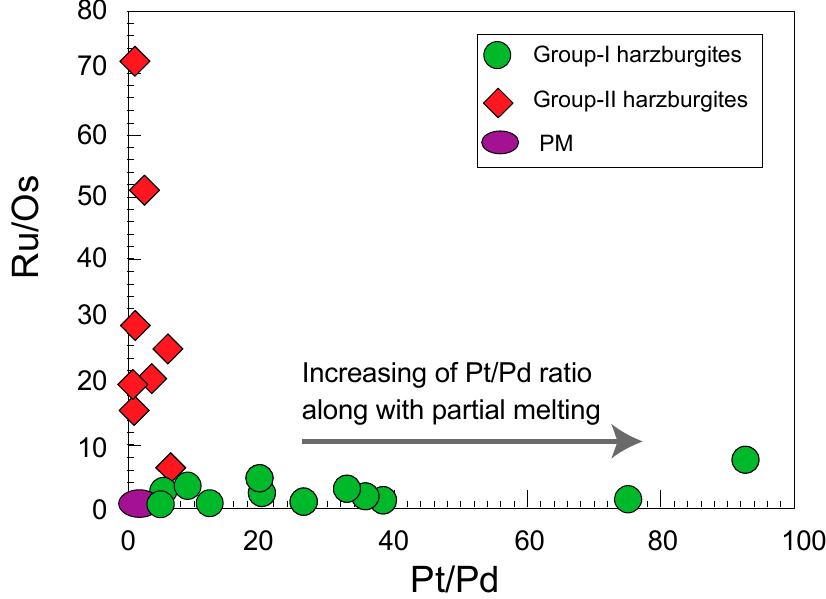
Figure 4. Ru / Os versus Pt / Pd of Me Maoya harzburgites. Increasing of Pt / Pd ratios result from formation of Pt-bearing phases along with hydrous melting.